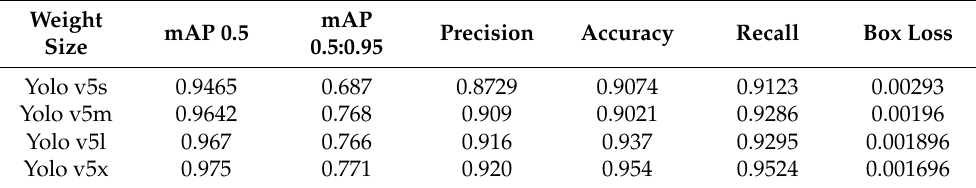
Table 4. Results obtained from the different weight